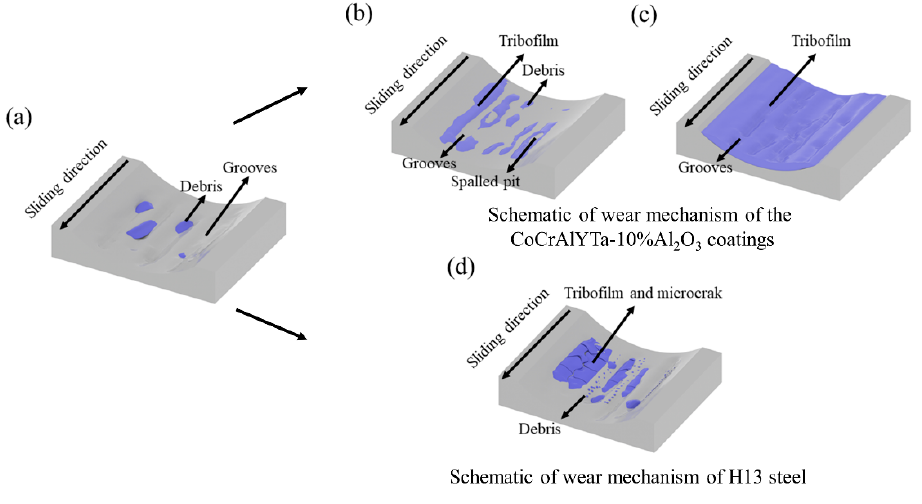
Figure 9. Schematic of wear mechanism of the CoCrAlYTa-10%Al 2 O 3 coatings and H13 steel.